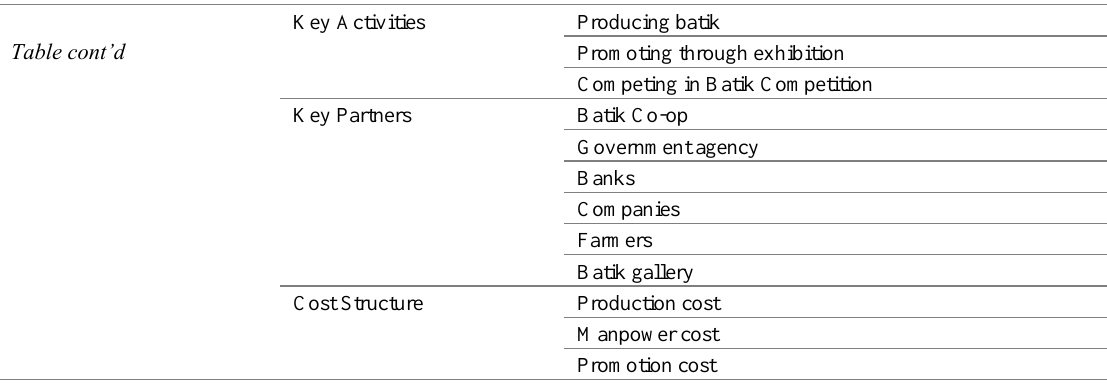
Key Activities Producing batik